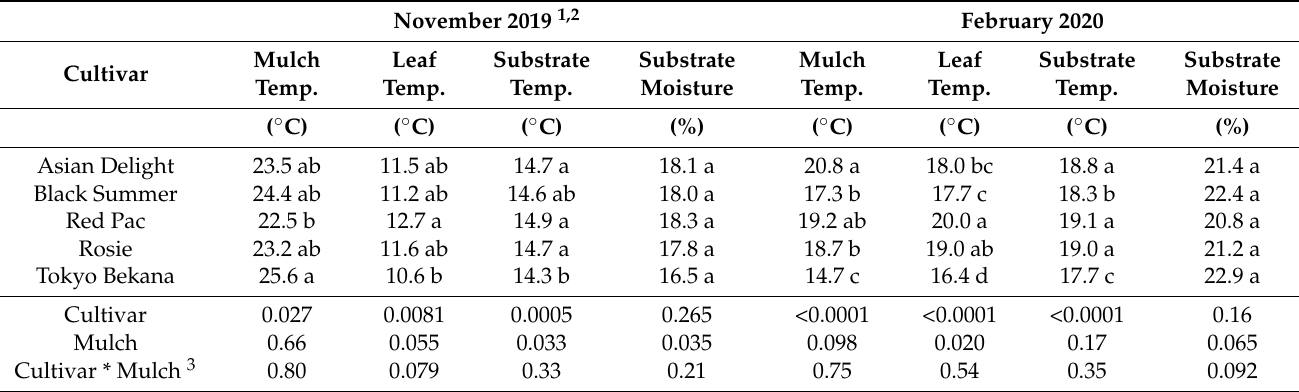
Table 5. Temperatures of mulch, leaf, substrate, and substrate moisture in five Asian green cultivars grown with four types of mulches in a high tunnel in Starkville, MS in two experiments.